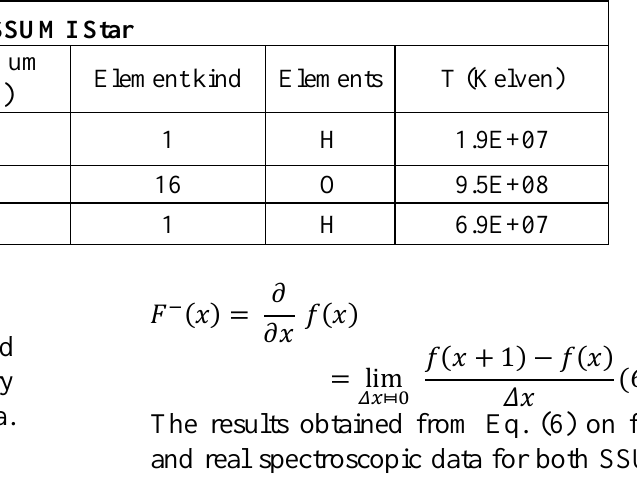
Table 2: Estimating parameters and computing temperatures in dwarf nova stars